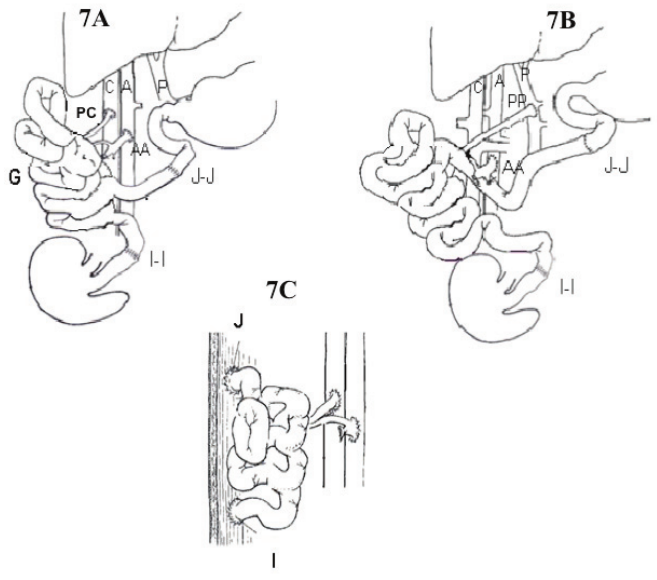
FIGURE 7 - Diagram showing the most used intestinal transplantation techniques in the rat. A. Orthotopic fashion with systemic graft drainage. B. Orthotopic fashion with portal graft drainage. C. Heterotopic